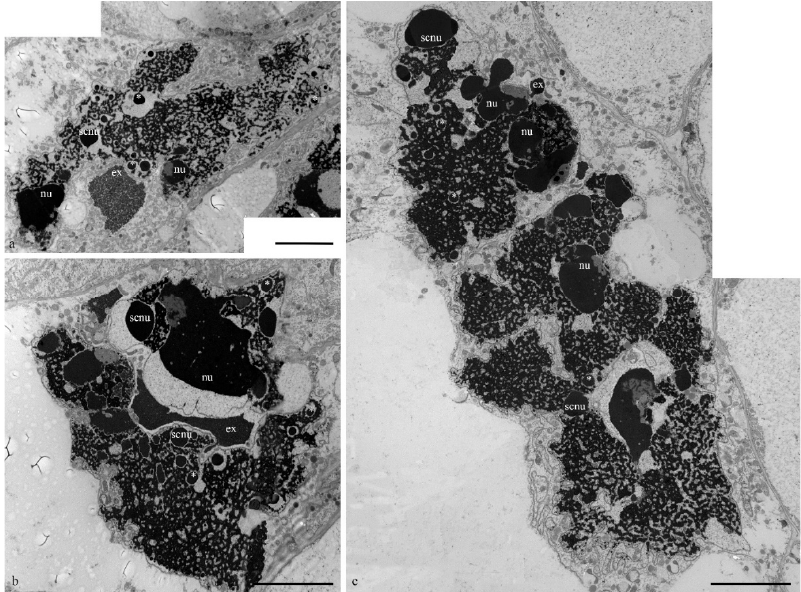
Figure 4. Ultrastructure of the wheat embryo sac nuclei at the middle and late stages of programmed cell death. Segregated nucleolus components in the lacunae of polytene chromosomes of antipodal nuclei ( a – c ) and nucleolus extrusion (ex). nu—nucleolus; scnu—large segregated nucleolus components, *—small segregated nucleolus components. The scale is 10 µm.